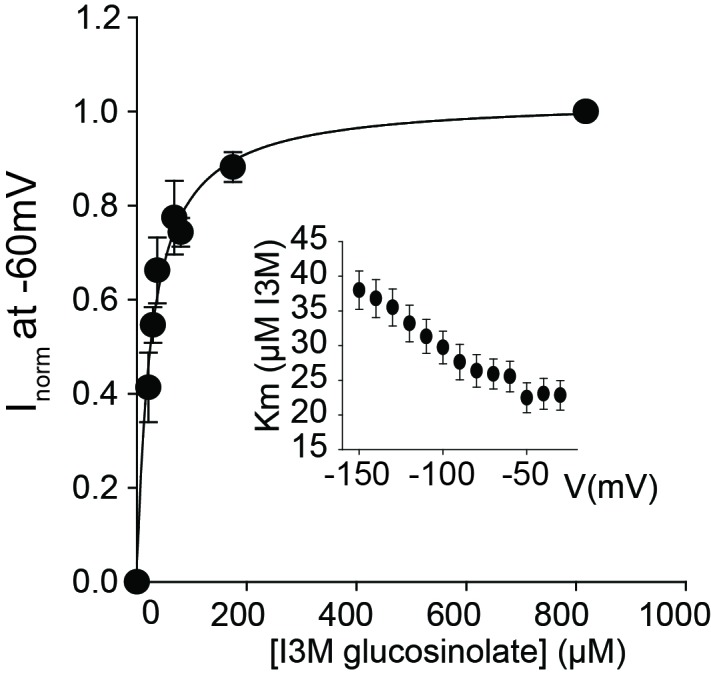
GTR2 indole glucosinolate Km measurement.Normalized I3M-induced currents of GTR2-expressing oocytes measured at a membrane potential of −60 mV and pH 5 were plotted against increasing I3M concentrations. The saturation curve was fitted with a Michaelis-Menten equation – represented by a solid line. Insert shows apparent Km as a function of clamped membrane potential. Each oocyte dataset was normalized to I3M-induced currents elicited at 0.8 mM I3M concentration at −60 mV. The insert shows the apparent Km as a function of membrane potential. Error bars represent ± s.e. of mean for data obtained from six different oocytes per experiment, experiment repeated two times.